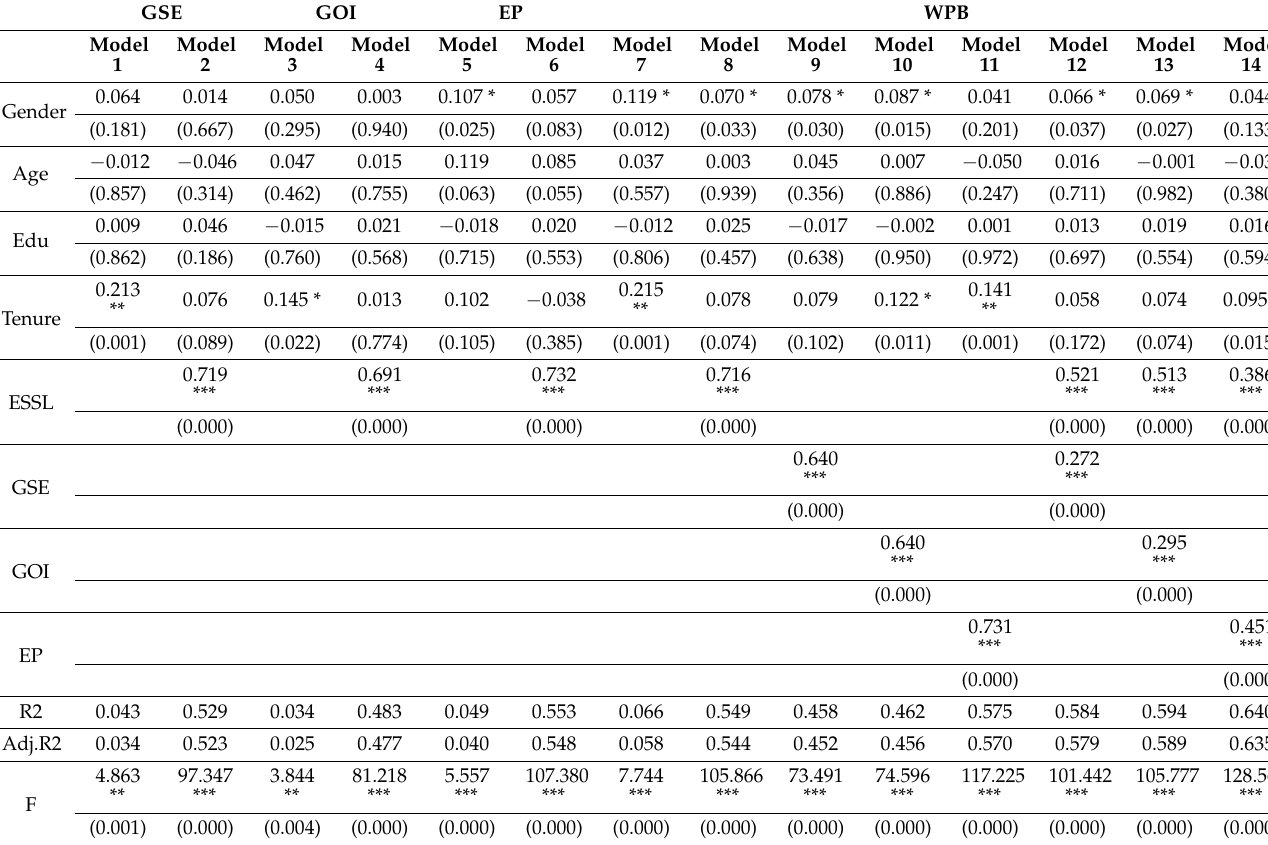
Table 4. Results of regression